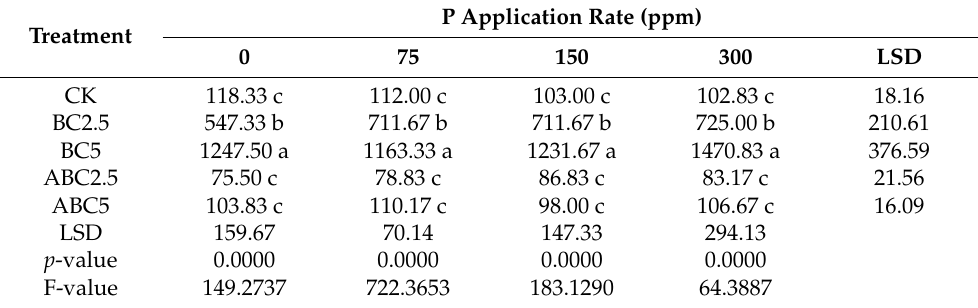
Table 4. Influence of BC and ABC applied at different rates with different P fertilizer application rates on soil Extractable K in